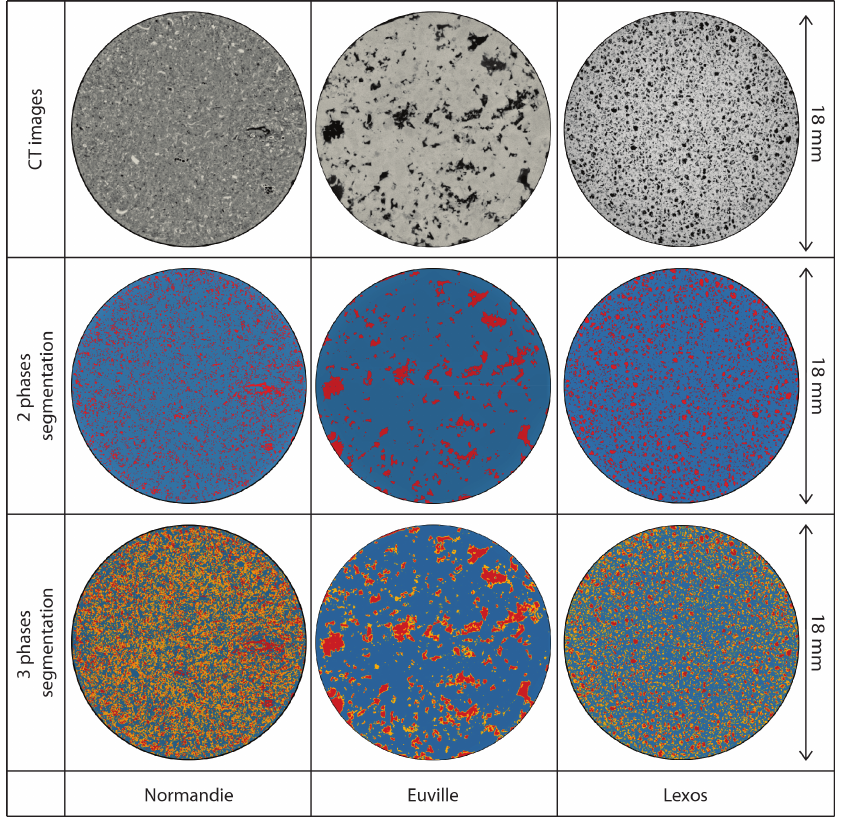
Figure 2. 2D slices obtained from 3D XRMT images. Blue color represents the matrix phase, red the macro-phase and orange the